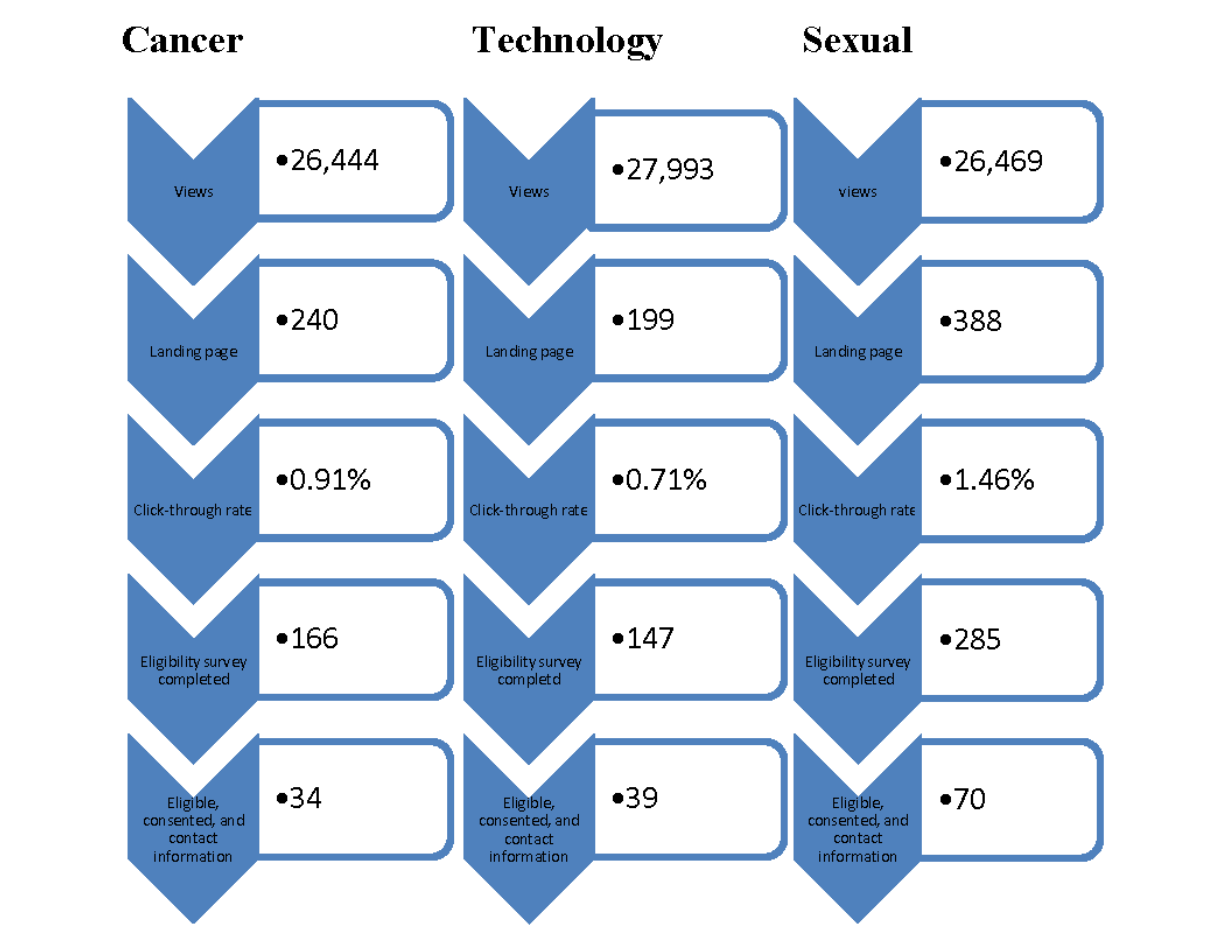
Figure 2. Sexual innuendo advertisement outperformed other